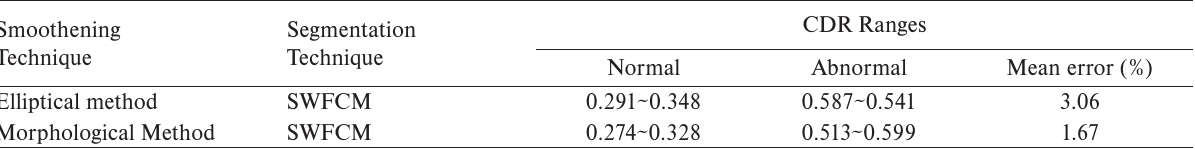
Table 2. CDR ranges and mean error of the proposed SWFCM